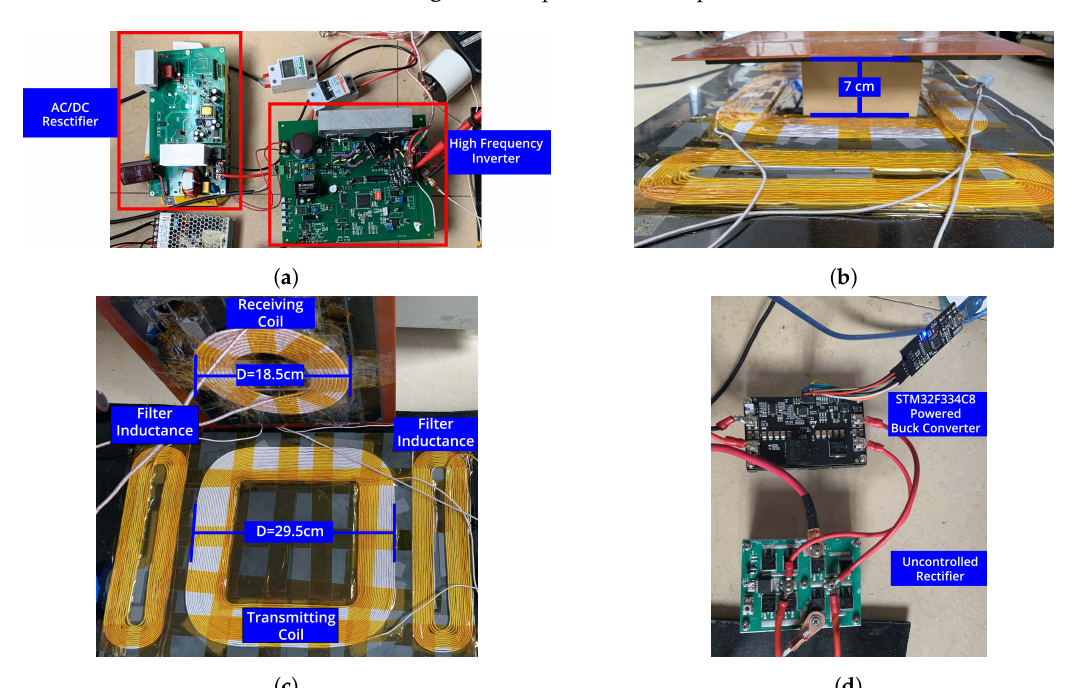
Figure 18. ( a ) AC/DC rectifier and high-frequency inverter. ( b ) Transmitting and receiving coils’ gap. ( c ) Transmitting and receiving coils. ( d ) Uncontrolled rectifier and buck